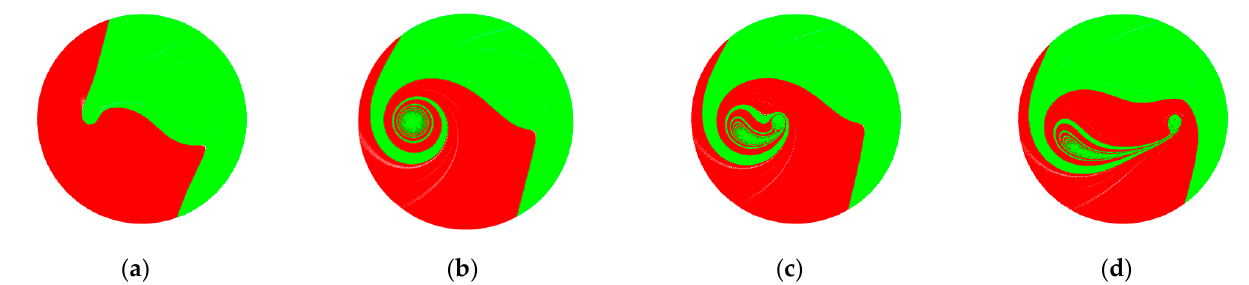
Figure 3. Particle distribution at ( a ) t = 0.5 (half period); ( b ) 0.85 (after the second fixed vortex); ( c ) 0.9 (under moving vortex); and ( d ) 1.0 (after a single period) with µ of 1, ν of 0.5, and r trans of 0.3.